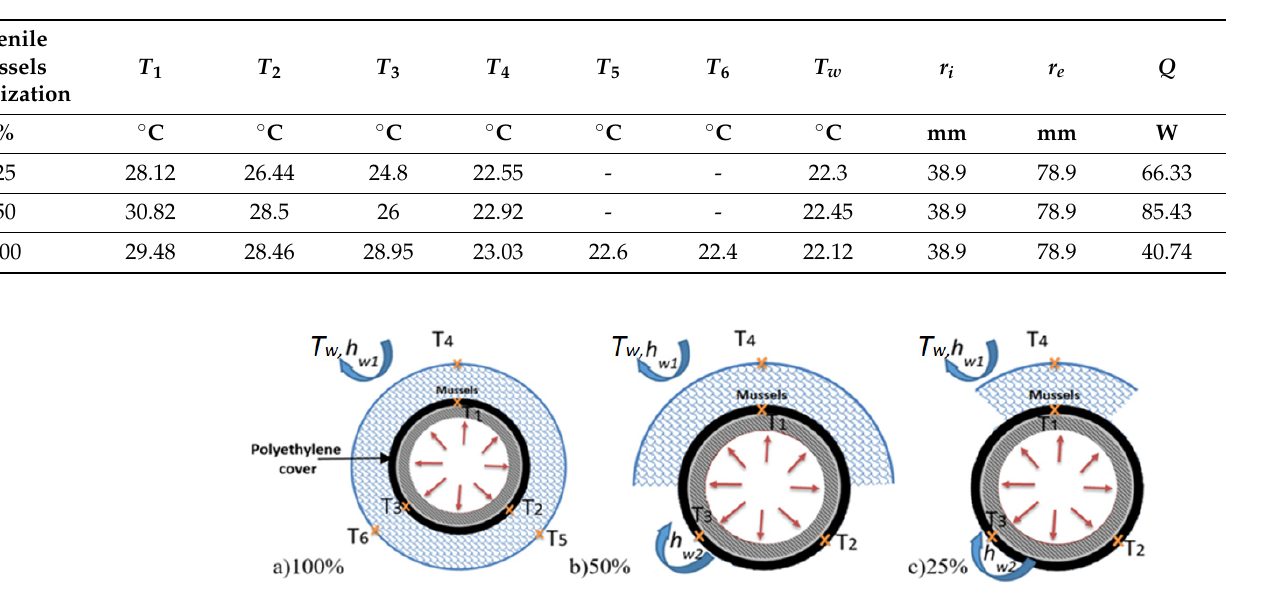
Table 6. Distribution of measured temperatures around a polyethylene covered aluminum tube colonized by juvenile mussels with different configurations of colonization.